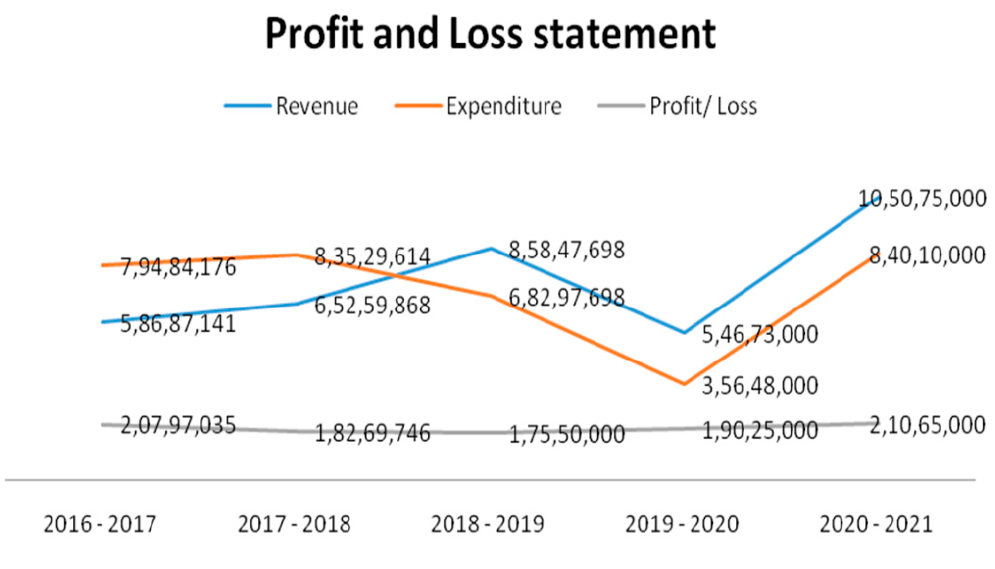
Figure 6. Line Graphs showing Profit and Loss statement (2016–2021).